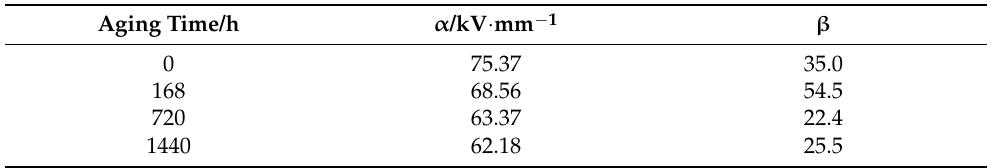
Table 1. Weibull distribution parameters for XLPE breakdown strength at different thermal ag- ing